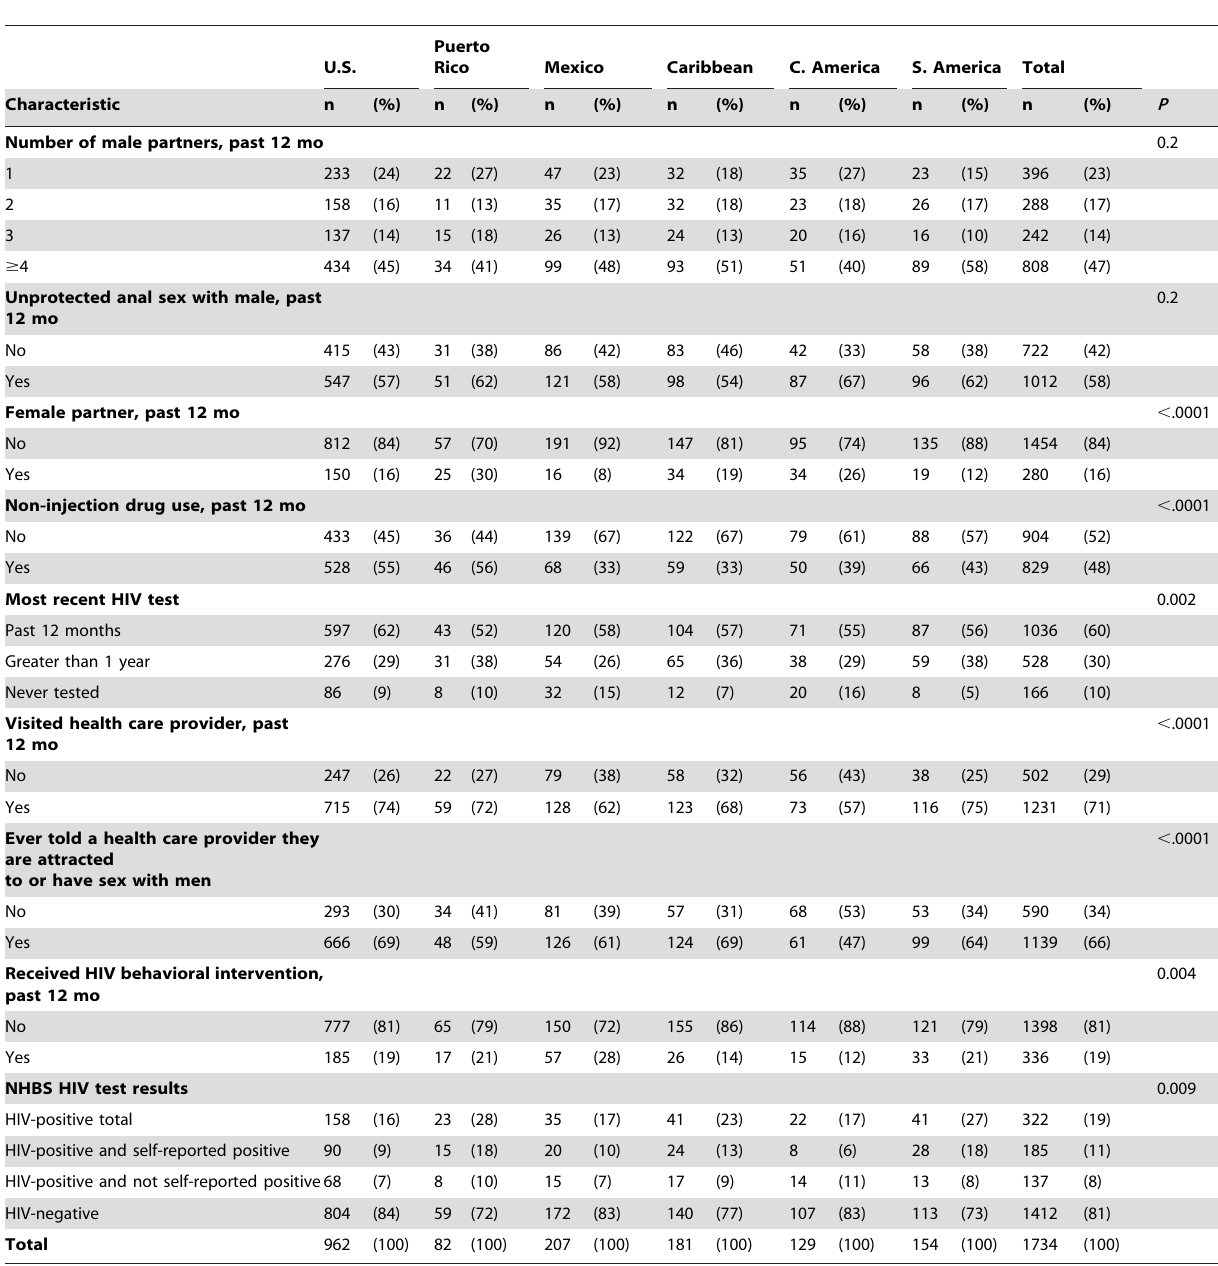
Table 2. Behaviors and HIV status of Latino MSM by location of birth – 20 U.S. Cities, National HIV Behavioral Surveillance System,